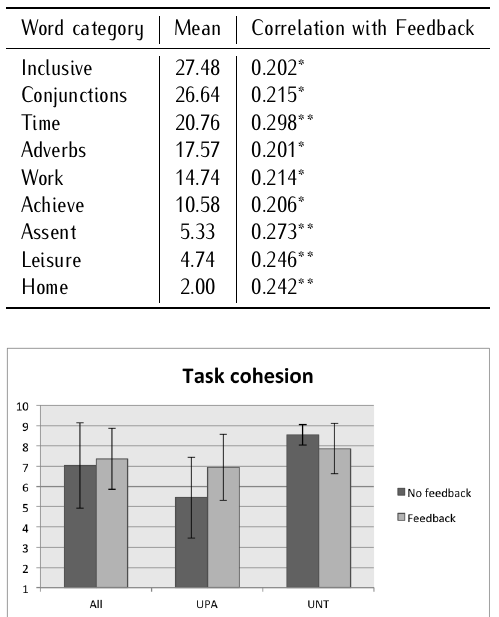
Table 4. Correlations between communication- and response- rate- measures and Individual grades. * p < 0 . 01 , ** p < 0 .